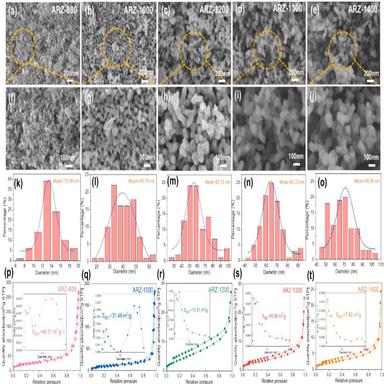
SEM, grain size distribution and BET images of fracture surfaces of ARZ after annealing: (a, f, k, p) ARZ-800, (b, g, l, q) ARZ-1000, (c, h, m, r) ARZ-1200, (d, I, n, s) ARZ-1300, (e, j, o, t) ARZ-1400.